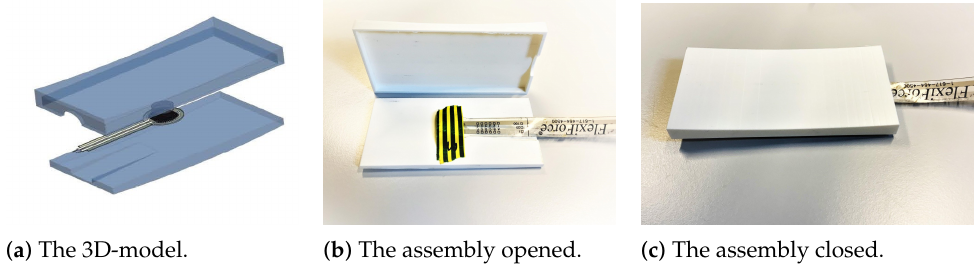
Figure 2. The 3D-model, the printed model and the assembly of the "U" shape. Figure 3. The 3D-model and the printed model of the concave shape, assembled with the sensors.